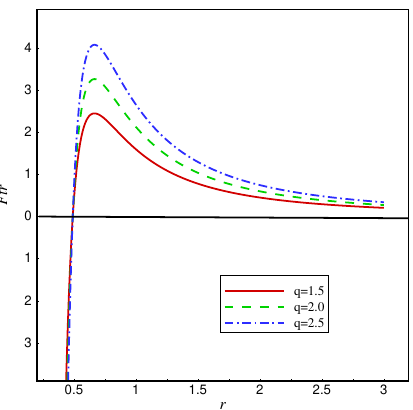
Figure 7 . The behavior of F tr ( r ) for charged rotating black string for di(cid:11)erent q . Here we have taken b = 1, (cid:3) = 2, (cid:4) = 1 : 2.